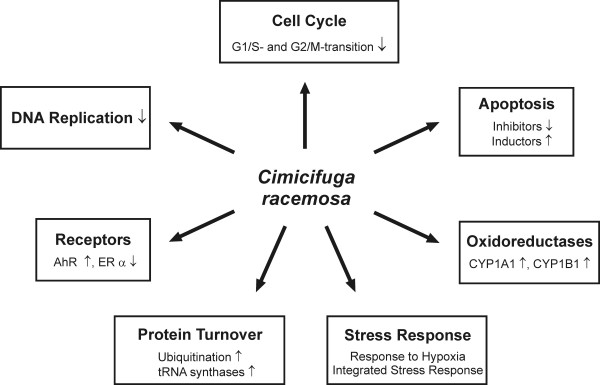
Summary of effects of black cohosh in MCF-7 cells at mRNA level observed with the microarray experiment. ↓ represents inhibition, ↑ represents stimulation.